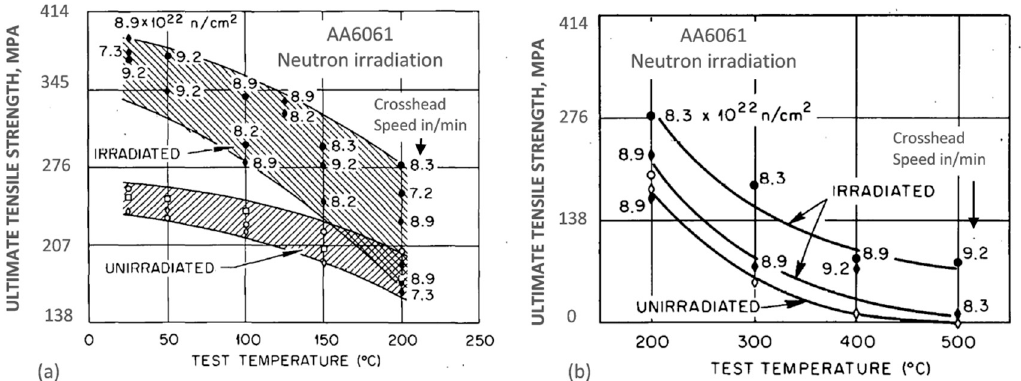
Figure5. E ff ectofneutronirradiationonthermalstabilityoftheAA6061aluminumalloyattemperatures Figure 5. Effect of neutron irradiation on thermal stability of the AA6061 aluminum alloy at below 200 ◦ C ( a ) and above 200 ◦ C up to 500 ◦ C ( b ) [17]. temperatures below 200 °C ( a ) and above 200 °C up to 500 °C ( b ) [17].